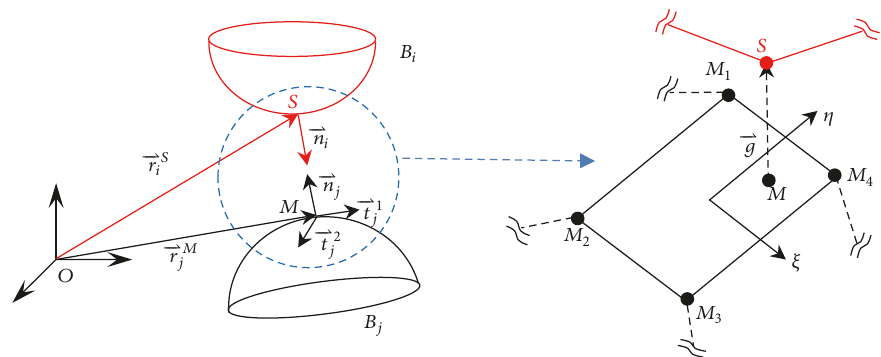
Figure 2: Node-to-segment contact